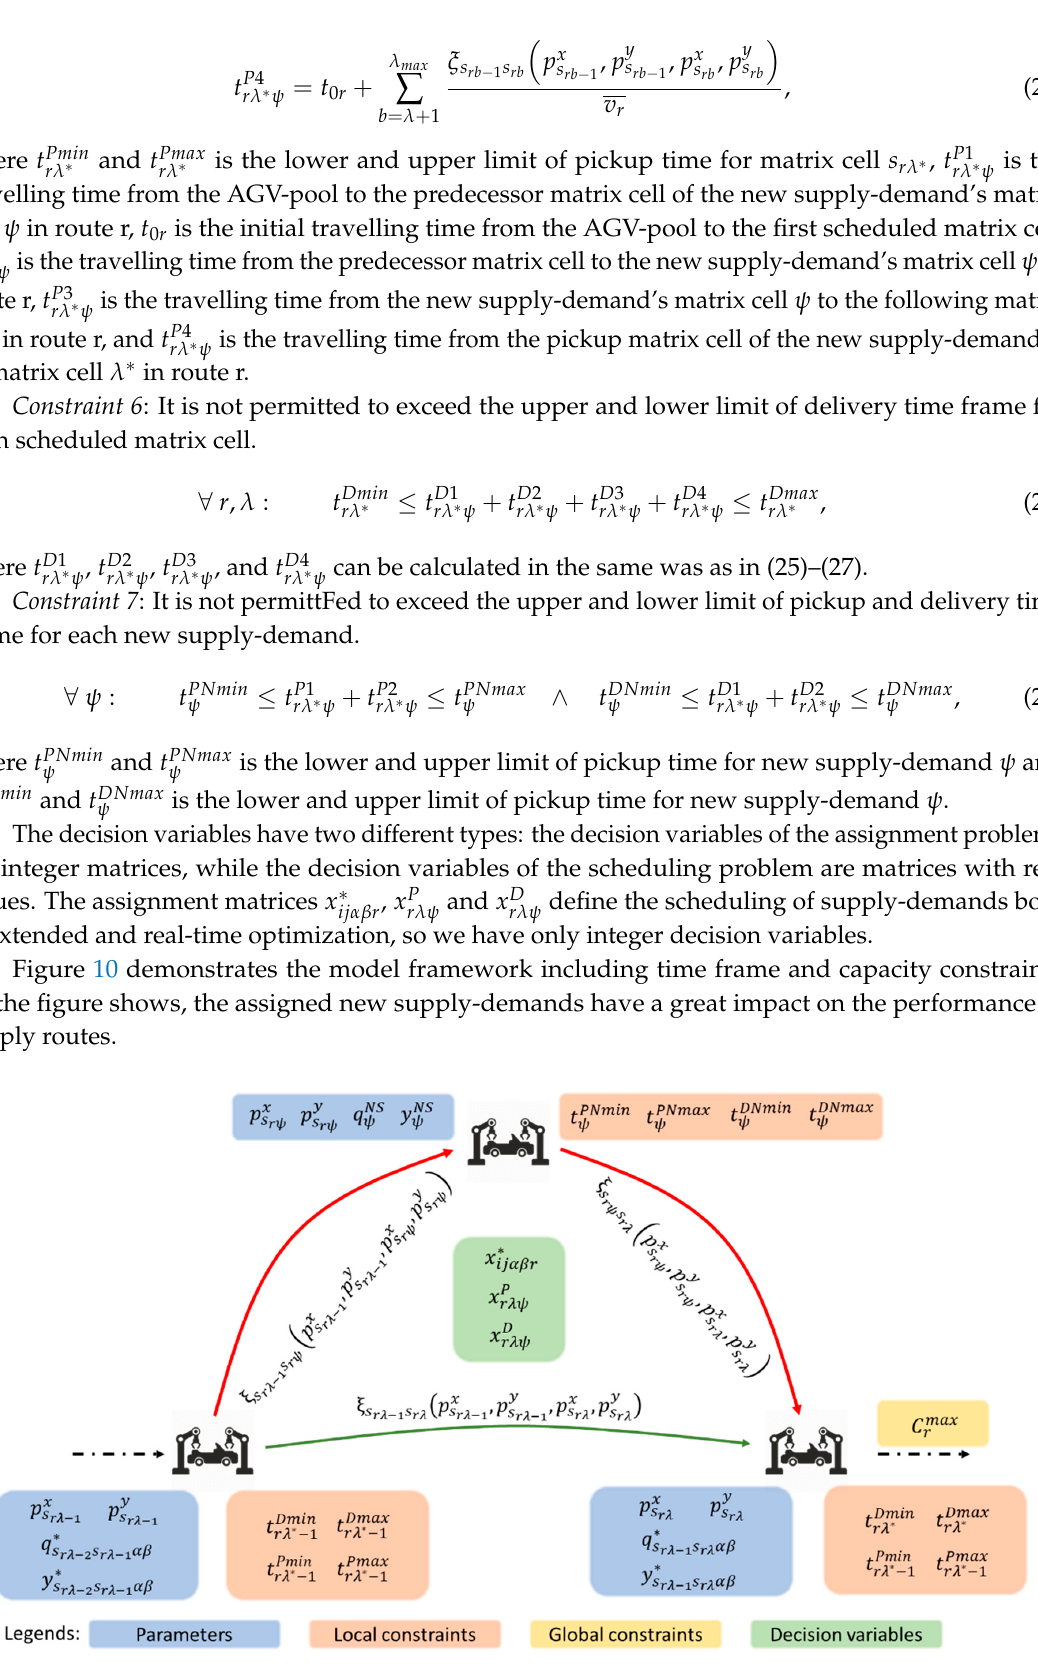
Figure 10. The structure of the mathematical model including parameters, local and global constraint and decision variables.